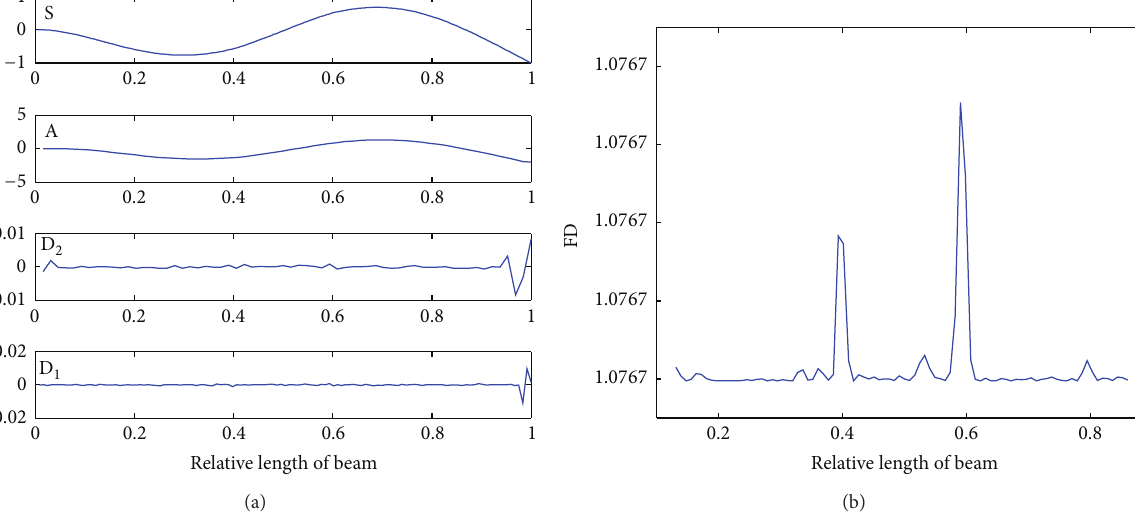
Figure 8: Crack location identification results in 100dB noise level for the third mode shape. (a) Noise contaminated the first mode shape S N and its wavelet decomposition at level 2. (b) FD of the detailed signal D 1 .